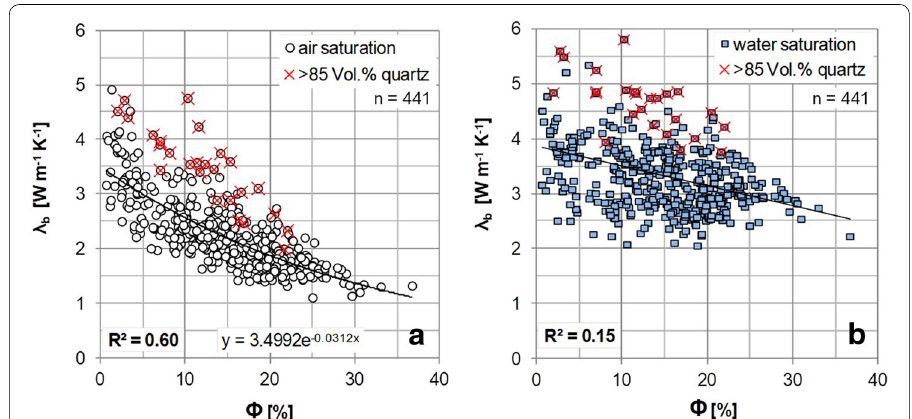
Fig. 8 Cross-plots of porosity ( Φ ) and measured bulk thermal conductivity ( λ b ) of a air-saturated sandstone samples and b water-saturated sandstone samples, showing a coefficient of determination R 2 of 0.60 and 0.15 only. λ b is measured parallel to bedding. Samples containing > 85 vol.% total quartz are highlighted by a red x, as they plot as